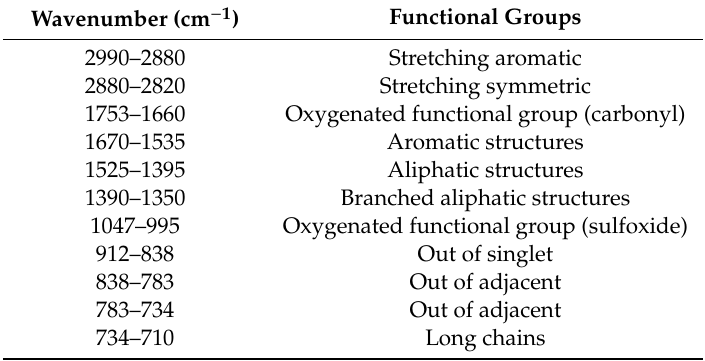
Table 2. Main functional groups of bitumen in Fourier transform infrared (FTIR)